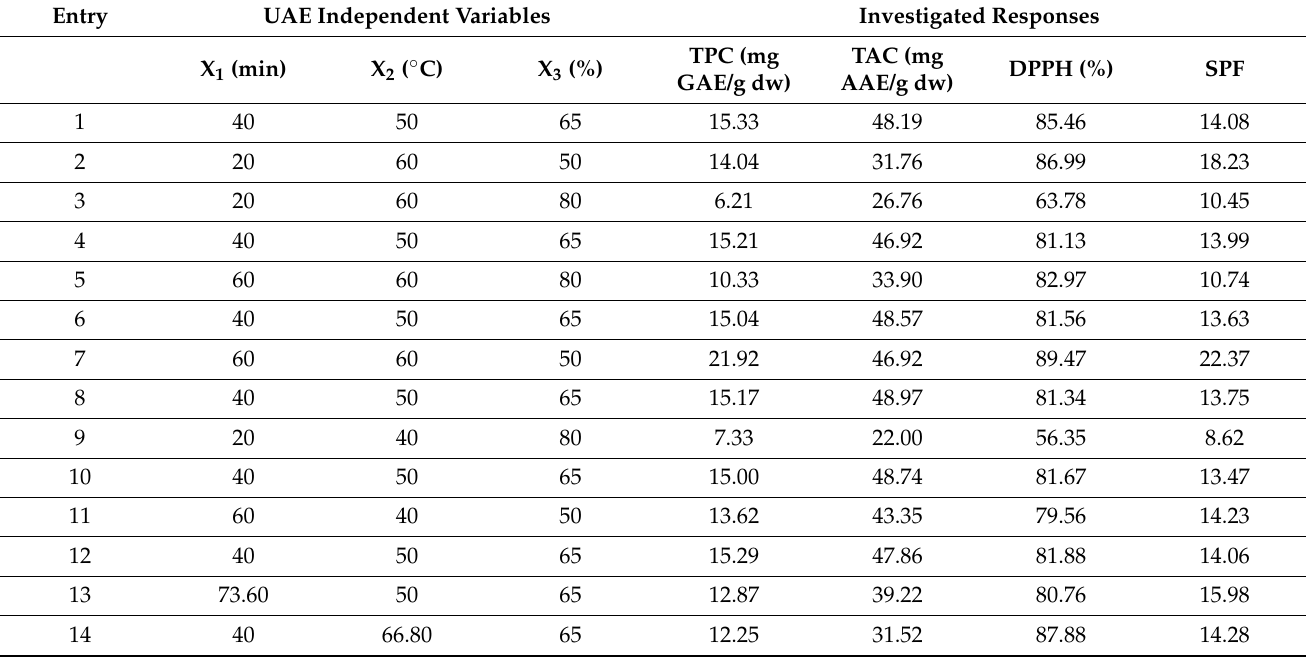
Table 1. Central composite design rotatable (CCDR) of three variables at three levels, and the resultant responses: TPC, TAC, DPPH, and